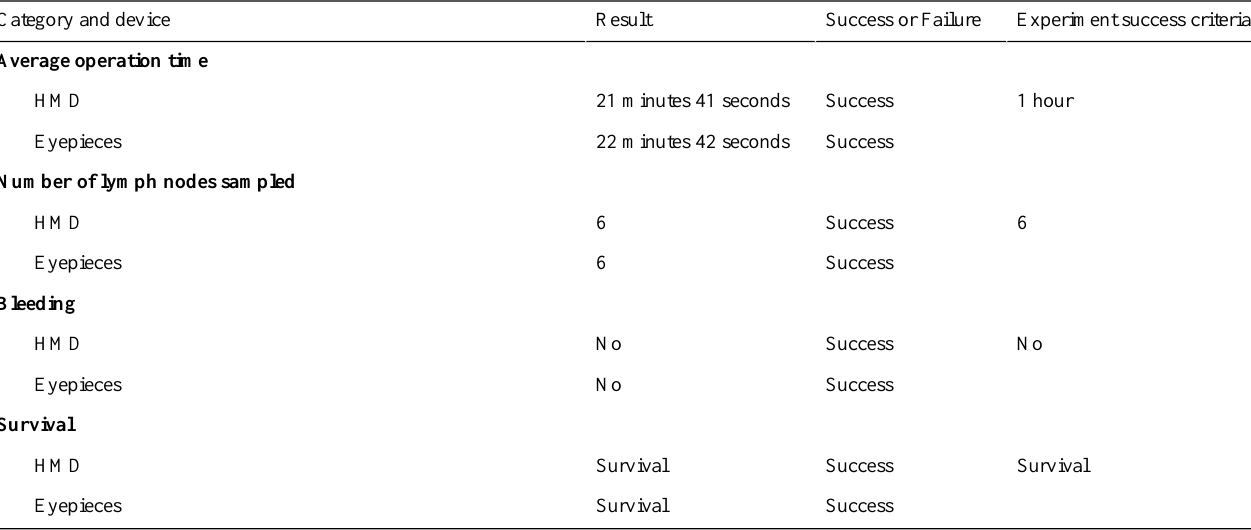
Table 3. Comparison of preclinical experiment results obtained using head-mounted display (HMD) and